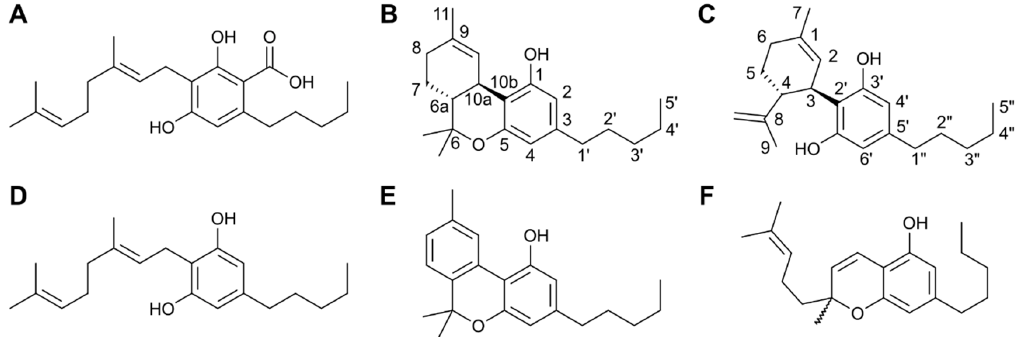
Figure 1. Chemical structures of the most common cannabinoids: ( A ) CBGA; ( B ) ∆ 9-THC, with the numbering convention included; ( C ) CBD, also numbered; ( D ) CBG; ( E ) CBN; and ( F ) CBC.